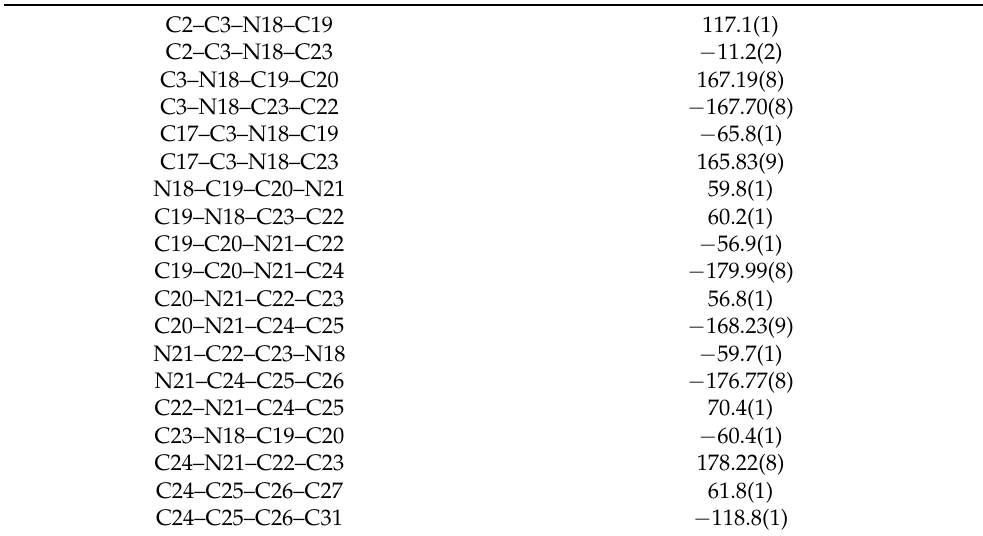
Table 1. Selected torsion angles ( ◦ ) for 2 .